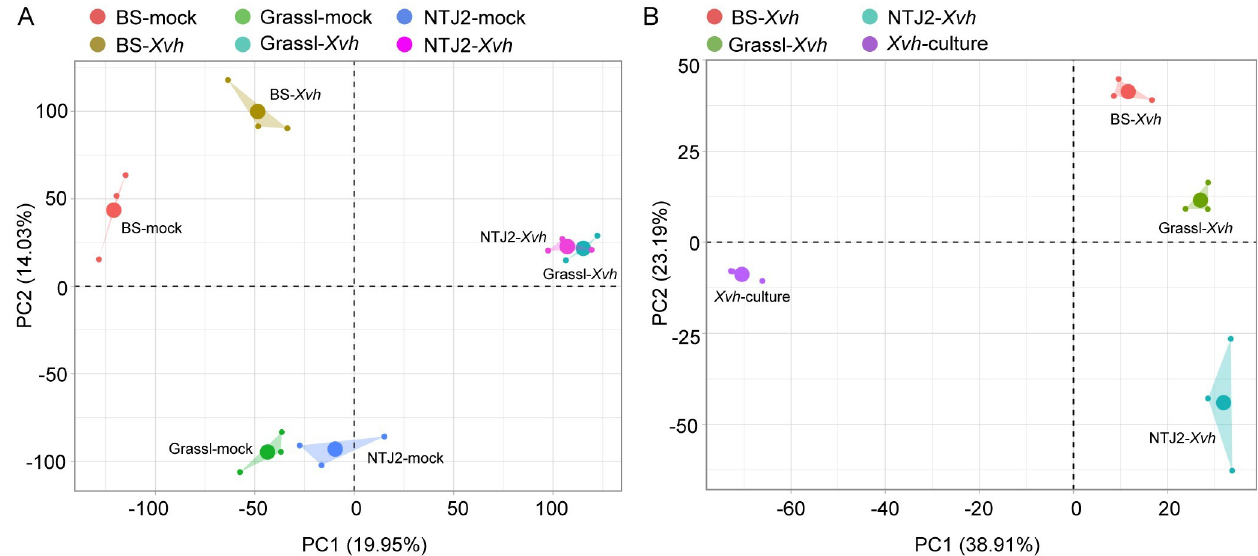
Fig 5. Principal component analysis (PCA) of the dual RNA-seq data. Within each cluster, three small dots represent individual replicates with the larger dot representing the average of the replicates. Reads were mapped against the concatenated reference genome comprised of sorghum nuclear genome, sorghum chloroplast genome, and mitochondrial genome (A) or the Xvh genome (B). BS (water-soaked lesions), Grassl (red lesions), and NTJ2 (resistance).